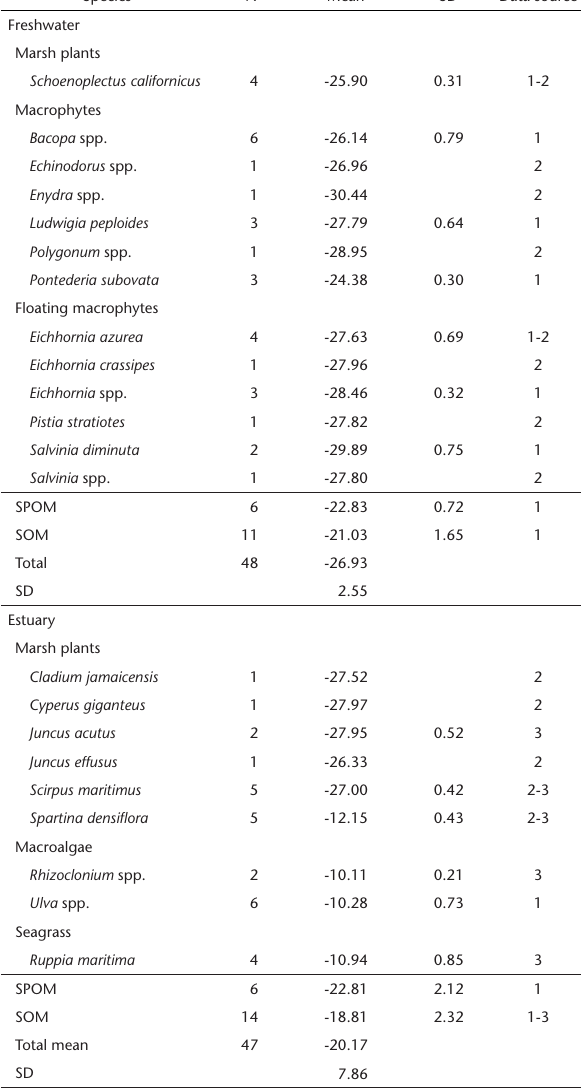
Table 1. Means and standard deviations (SD) of carbon isotope ratios ( d 13 C of primary producers, SPOM and SOM used to build the isotopic baseline of freshwater and estuarine reaches of Patos Lagoon. Data source: (1) This study, (2) G arcia et al. 2007, (3) c laudino et al. 2013.